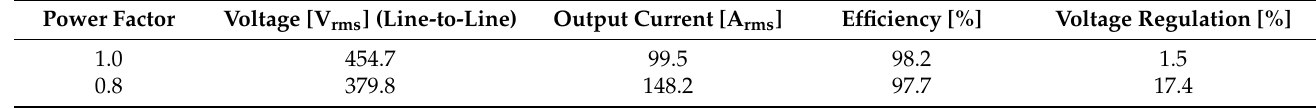
Table 5. Analysis results of load drive with 1800 rpm and 78 kW.